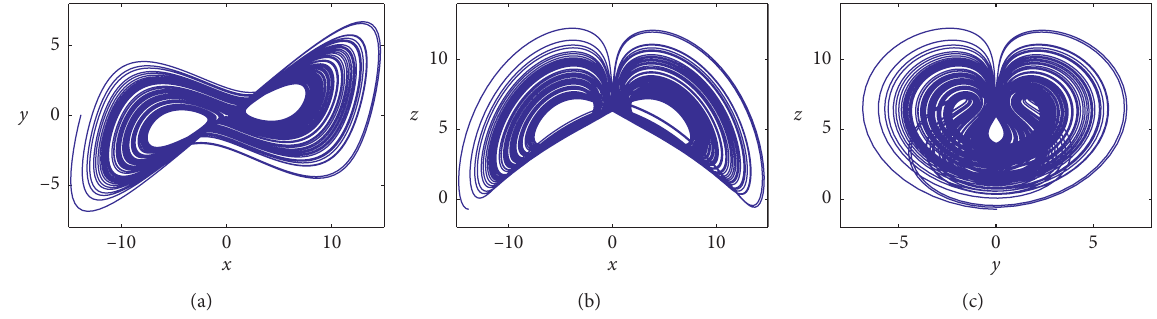
Figure 2: Phase portraits of system (3) with a � 2, b � 3, c � 5, and d � 0.75: (a) x - y plane, (b) x - z plane, and (c) y - z plane.